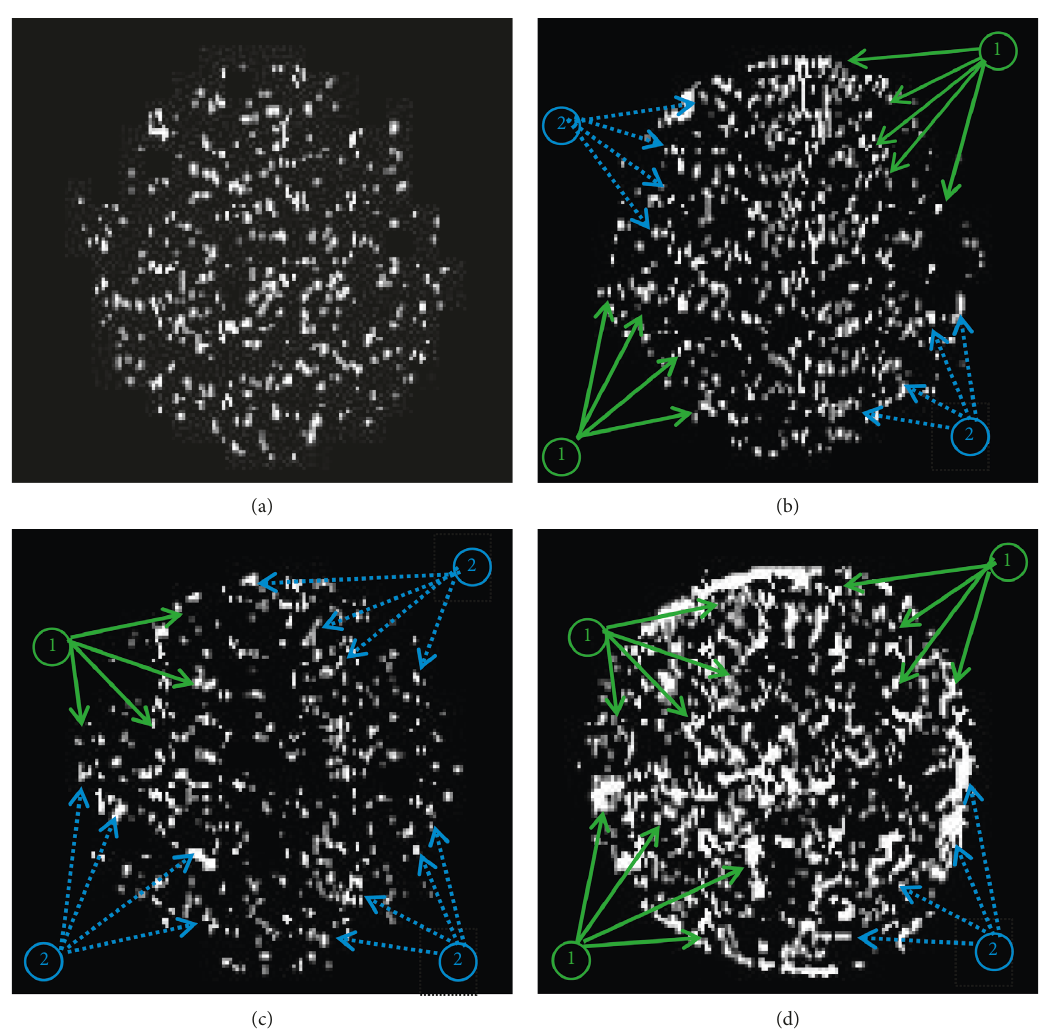
Figure 8: Images of sandstones of the pure water group after different numbers of freeze-thaw cycles: (a) 0; (b) 10; (c) 20; (d) 30. Two different kinds of pore deformation are approximately labelled by ① which indicates new pores are generated and ② which indicates pores are deformed to larger